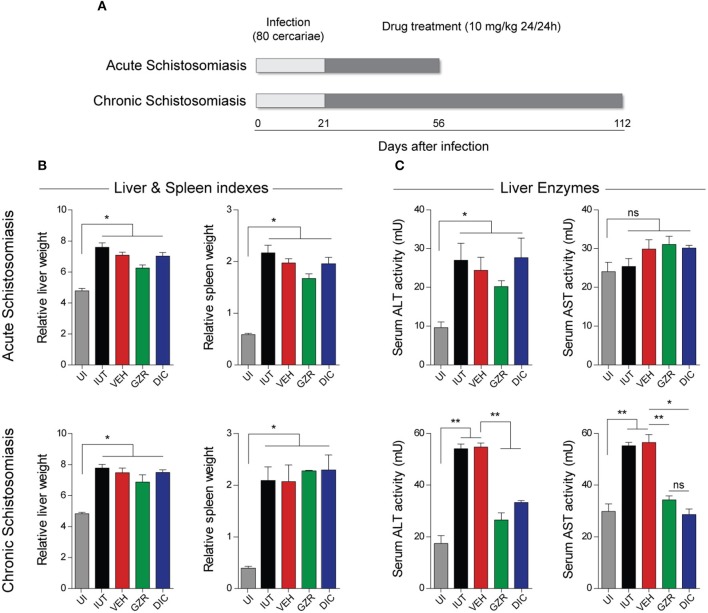
Experimental design, relative organs weights and liver enzyme activities. (A) BALB/c mice were infected with 80 S. mansoni cercariae. Mice with acute or chronic schistosomiasis were treated with daily doses of vehicle (4% propylene-glycol), or anti-HMGB1 inhibitors, Glycyrrhizin (GZR) and 3-chloro-5-(4-pyridyl)-4,5-dihydroisoxazole (DIC), both at a dose of 10 mg/kg, starting on day 21 post-infection and proceeding until day 56 in the case of acute schistosomiasis or day 112 in chronic schistosomiasis. Mice were divided into five groups as follows: uninfected mice (UI), infected and untreated mice (IUT), infected mice that received vehicle (VEH), GZR or DIC. The analyses were conducted with 40 animals per group for acute schistosomiasis and 15 animals per group for chronic schistosomiasis. (B) Measurements of the relative weight of the organs in acute and chronic schistosomiasis. The relative weights were calculated with the following equation: Relative organ weight = (absolute organ weight / body weight) × 100. (C) Determination of the activities of alanine aminotransferase (ALT) and aspartate amino transferase (AST) in the sera of acute and chronic schistosomiasis. All results (from 40 animals for acute and 15 for chronic infections) are presented as the mean ± SEM and were tested by ANOVA Tukey's multiple comparisons test. *P < 0.05 or **P < 0.0001 was considered statistically significant; ns—not significant. The P-values for all comparisons are available in Table S3.